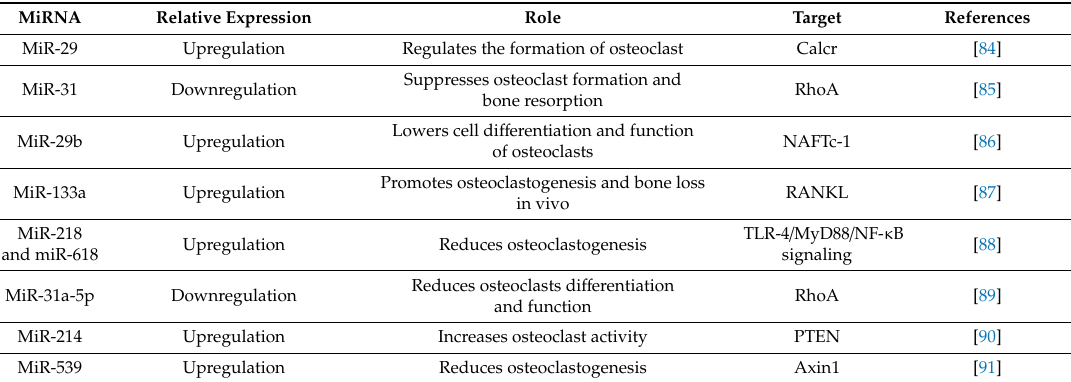
Table 4. MiRNAs involved in osteoclast